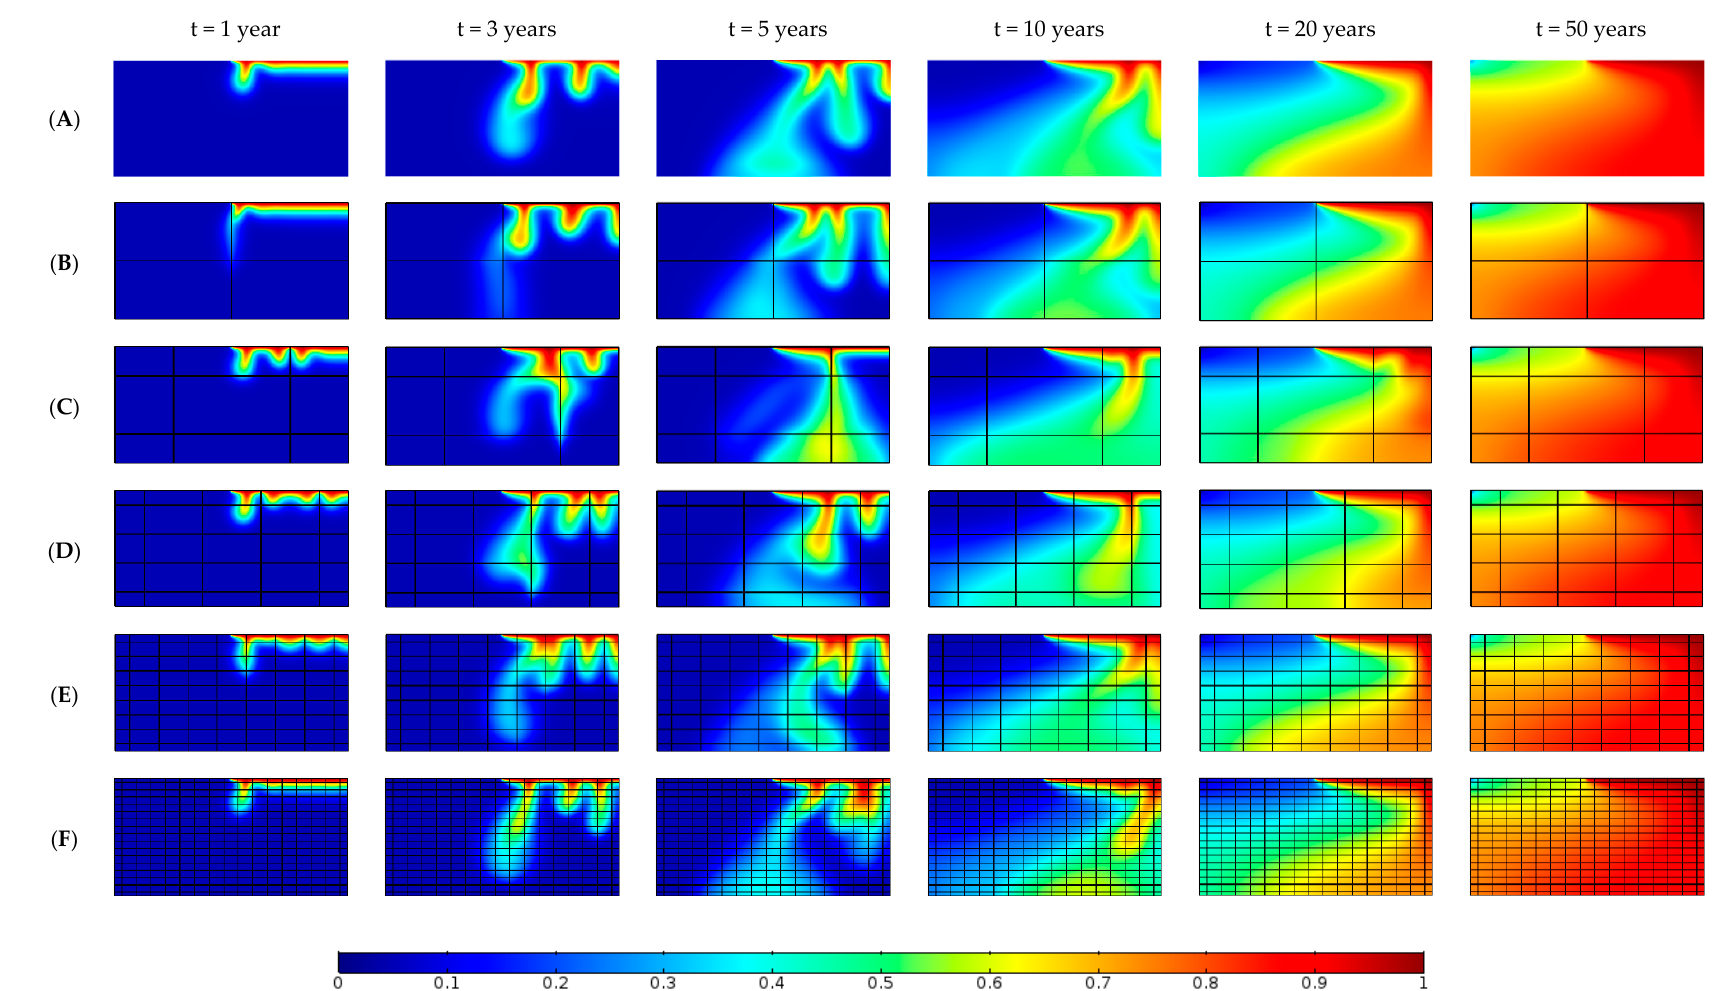
Figure 12. Solute distribution of half of domain of all the scenarios at simulation times of 1, 3, 5, 10, 20 and 50 years.